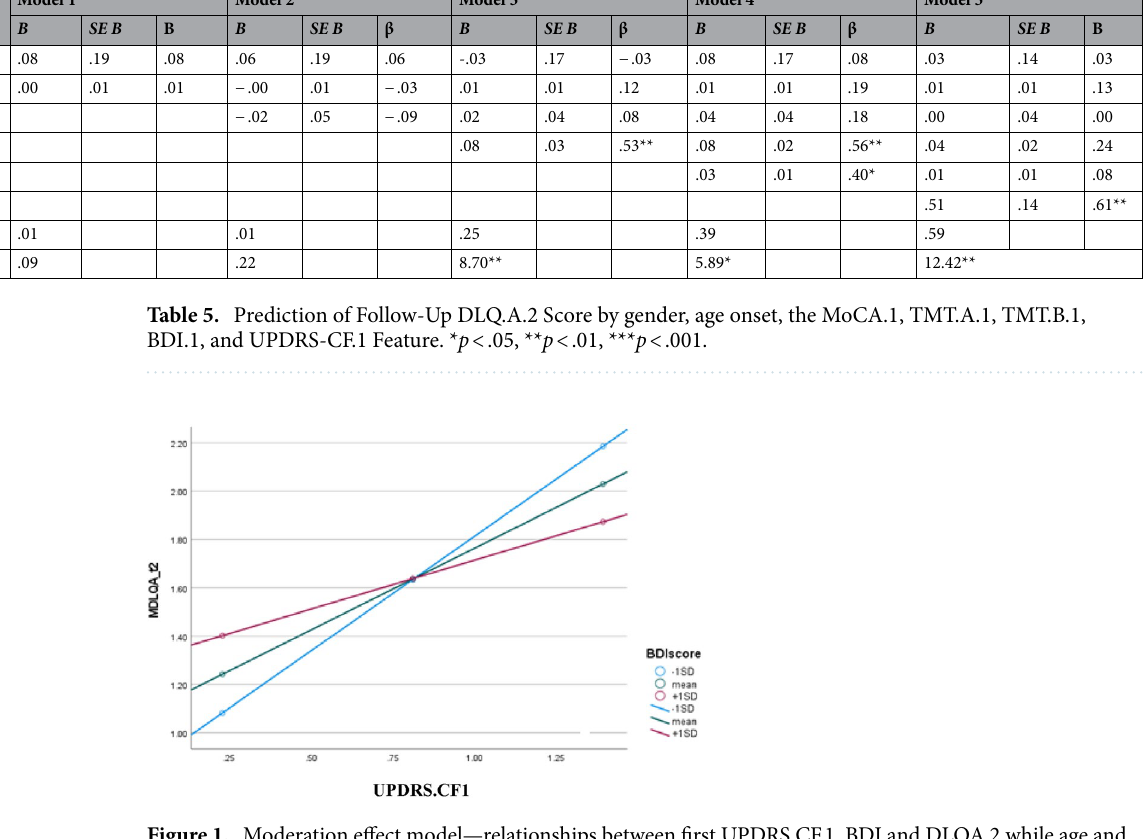
Figure 1. Moderation effect model—relationships between first UPDRS.CF.1, BDI and DLQA.2 while age and years with PD were entered as